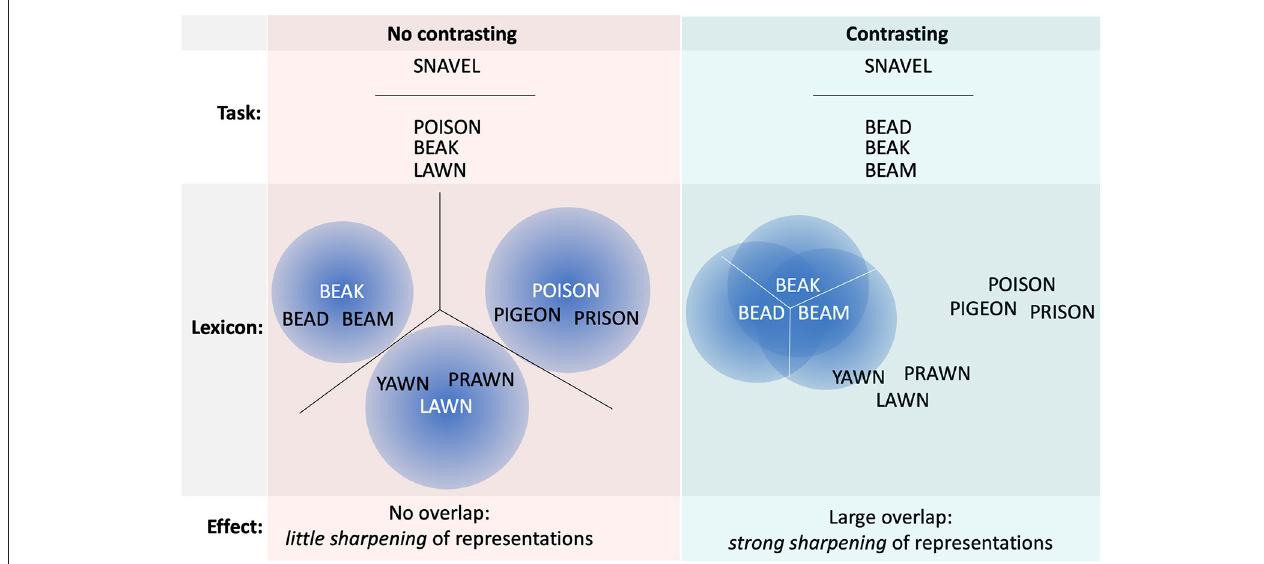
FIGURE 1 | Schematic overview of the expected difference between the no contrasting and contrasting condition. Task shows the used multiple-choice task; Lexicon contains the to-be-learned words, sorted by orthographic similarity in this example; Effect highlights the expected effect on the representations. When not contrasting (left; red), the fuzzy representations (blue gaussian circles) activated for the presented words are not overlapping, hence little sharpening of the representations ensues. When contrasting (right; cyan), the words to be distinguished are largely overlapping, hence the representations need to be sharpened to differentiate the words (white lines).